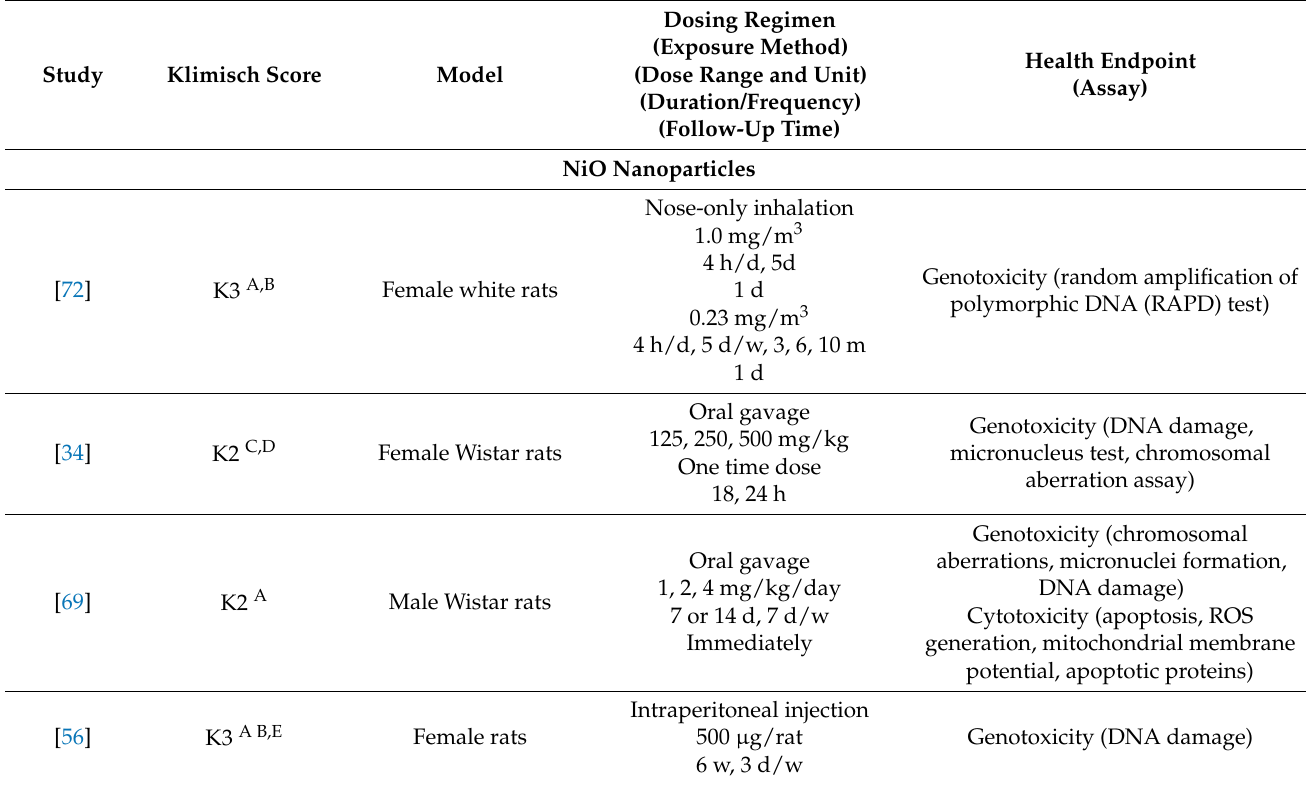
Table 4. In vivo literature associated with genotoxic endpoints after exposure to oxidic nickel nanoparticles. Studies are arranged by nanoparticle type, followed by exposure